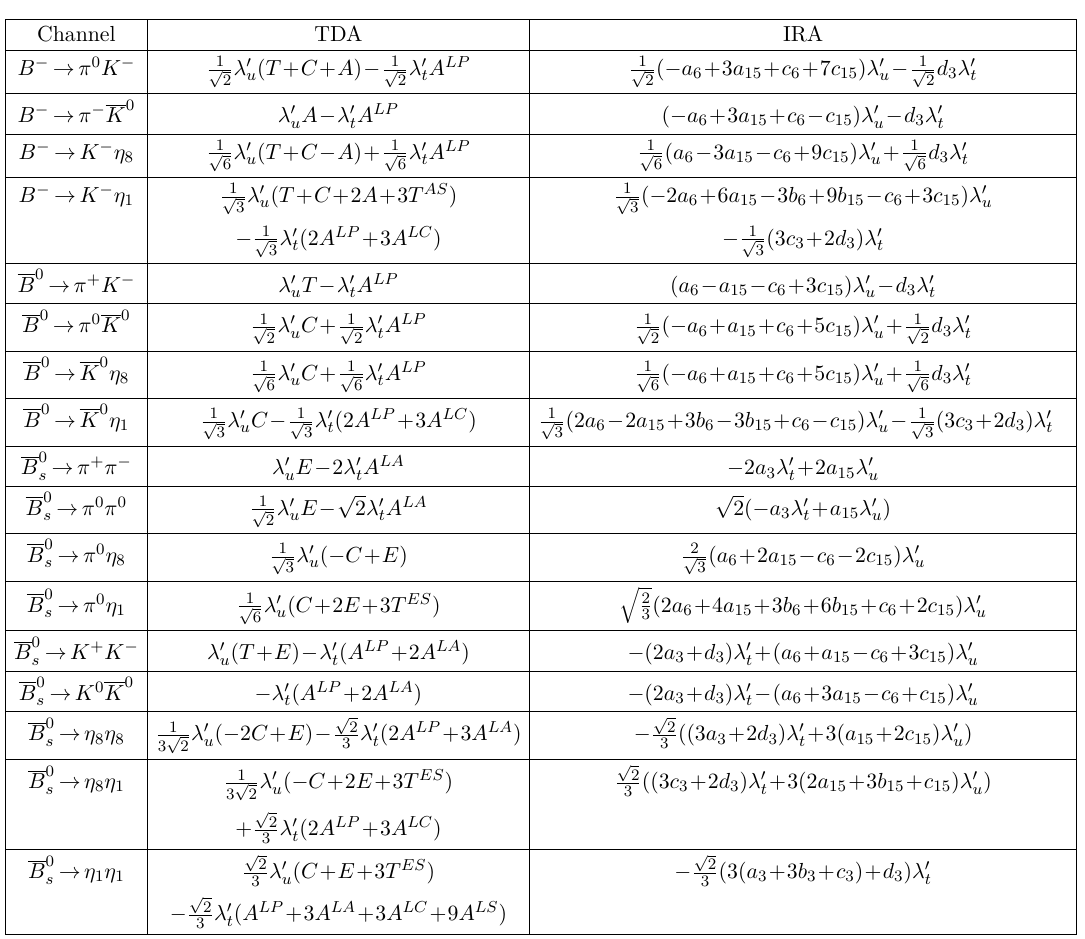
Table 4 . Decay amplitudes of the B → PP decays induced by the b − s